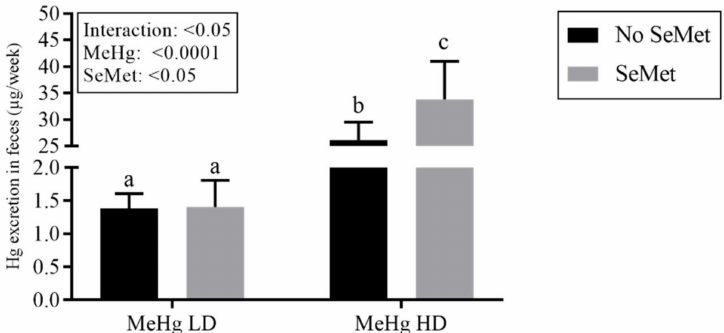
Figure 2. Total Hg concentration in feces after one-week continuous sampling ( µ g Hg/week). The results are presented as means with 95% CI ( n = 6). These data did not pass the assumption of heterogeneity of variance and was therefore analyzed using robust ANOVA. The box denotes p -values from two-way ANOVA analysis showing MeHg (main effect), SeMet (main effect) and interaction between MeHg and SeMet. Different lowercase letters represent statistical significance ( p < 0.05)